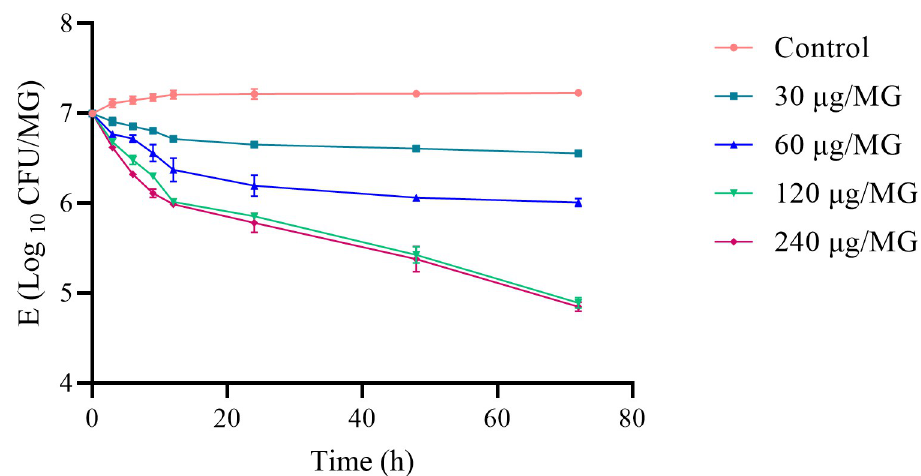
PLOS ONE | https://doi.org/10.1371/journal.pone.0278306 January 25,